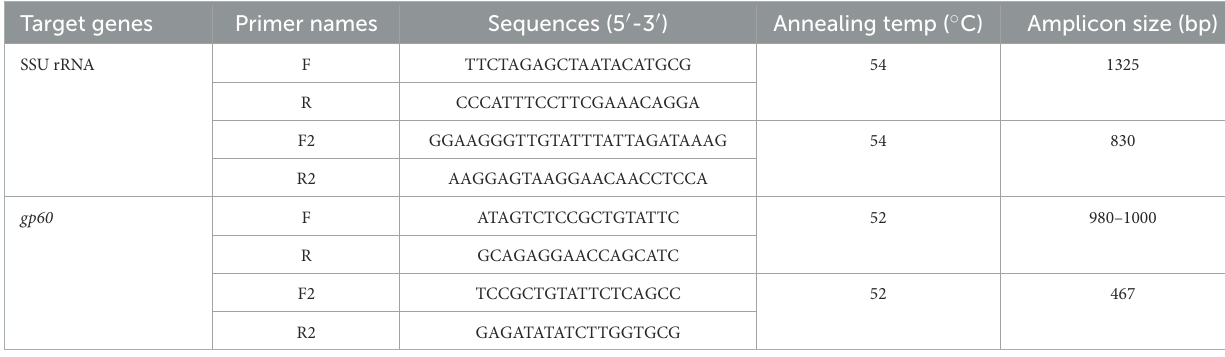
TABLE 1 Primers used for the detection of Cryptosporidium